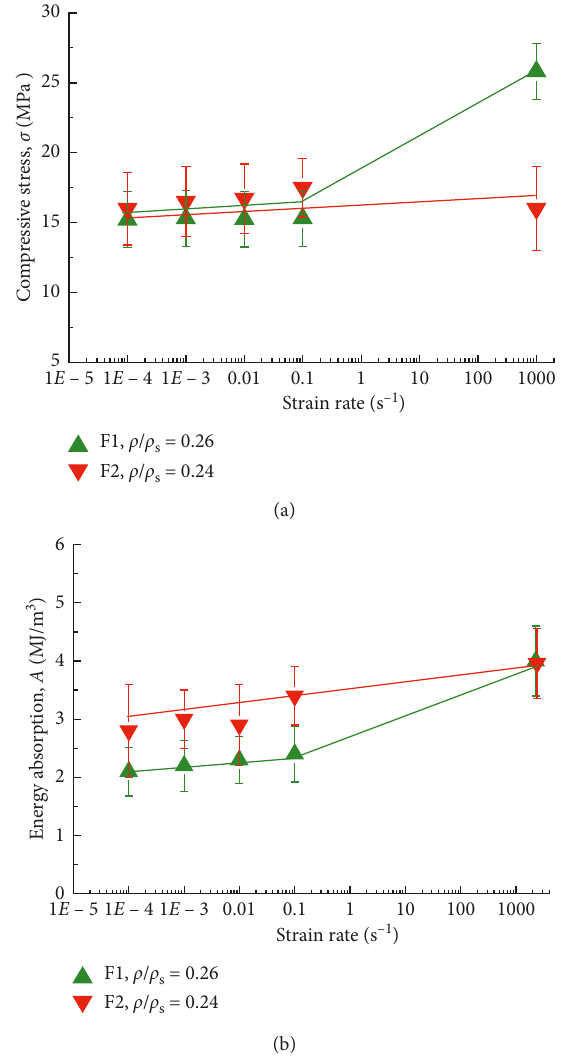
Figure 9: Variation of (a) strength and (b) energy absorption with the increasing strain rate for two kinds of Al foams (F1 and